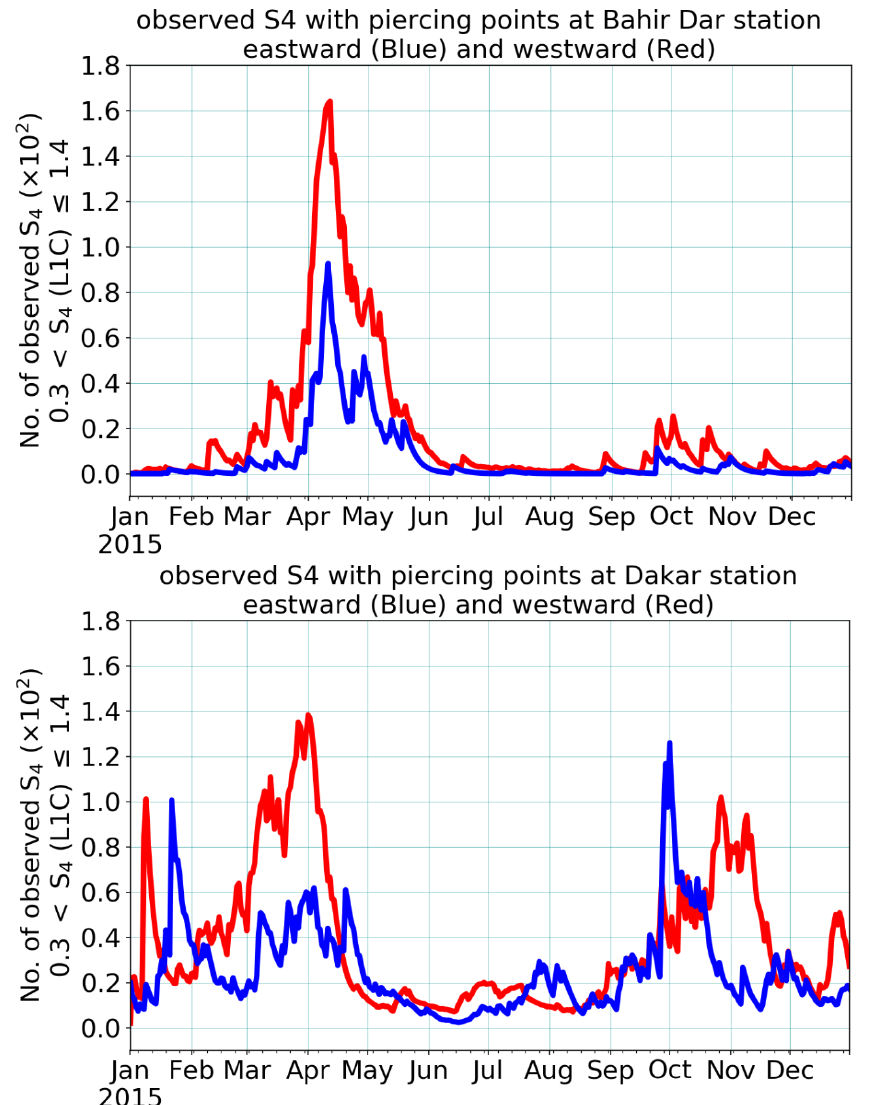
Figure 9. Seasonal S 4 scintillation occurrence at Bahir Dar ( upper panel ) and Dakar ( lower panel ) separated for eastward- (blue) and westward-looking (red) satellite-receiver